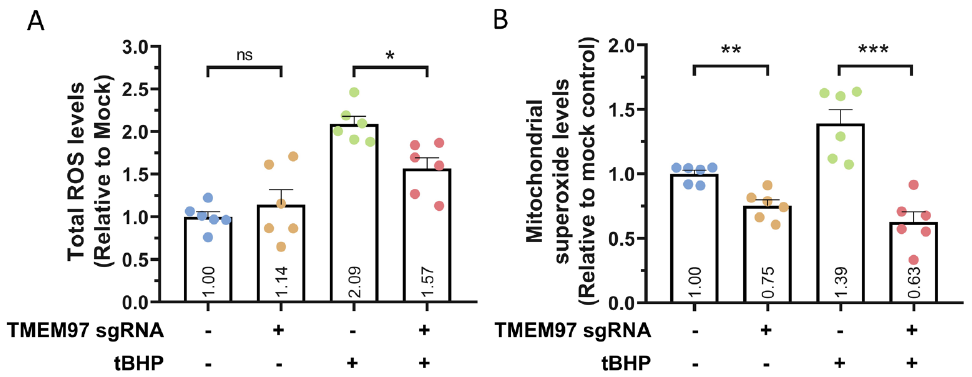
Figure 4. TMEM97 knockdown resulted in reduced ROS levels. Quantification of ( A ) total ROS levels using CellRox assay and ( B ) mitochondrial superoxide levels using MitoSox assay, following TMEM97 knockdown in ARPE19-KRAB in the presence or absence of tBHP. n = 6 repeats from 2 independent experiments, error bars represented SEM; ns indicates not significant; * indicates p < 0.05, ** indicates p < 0.01, *** indicates p < 0.001.